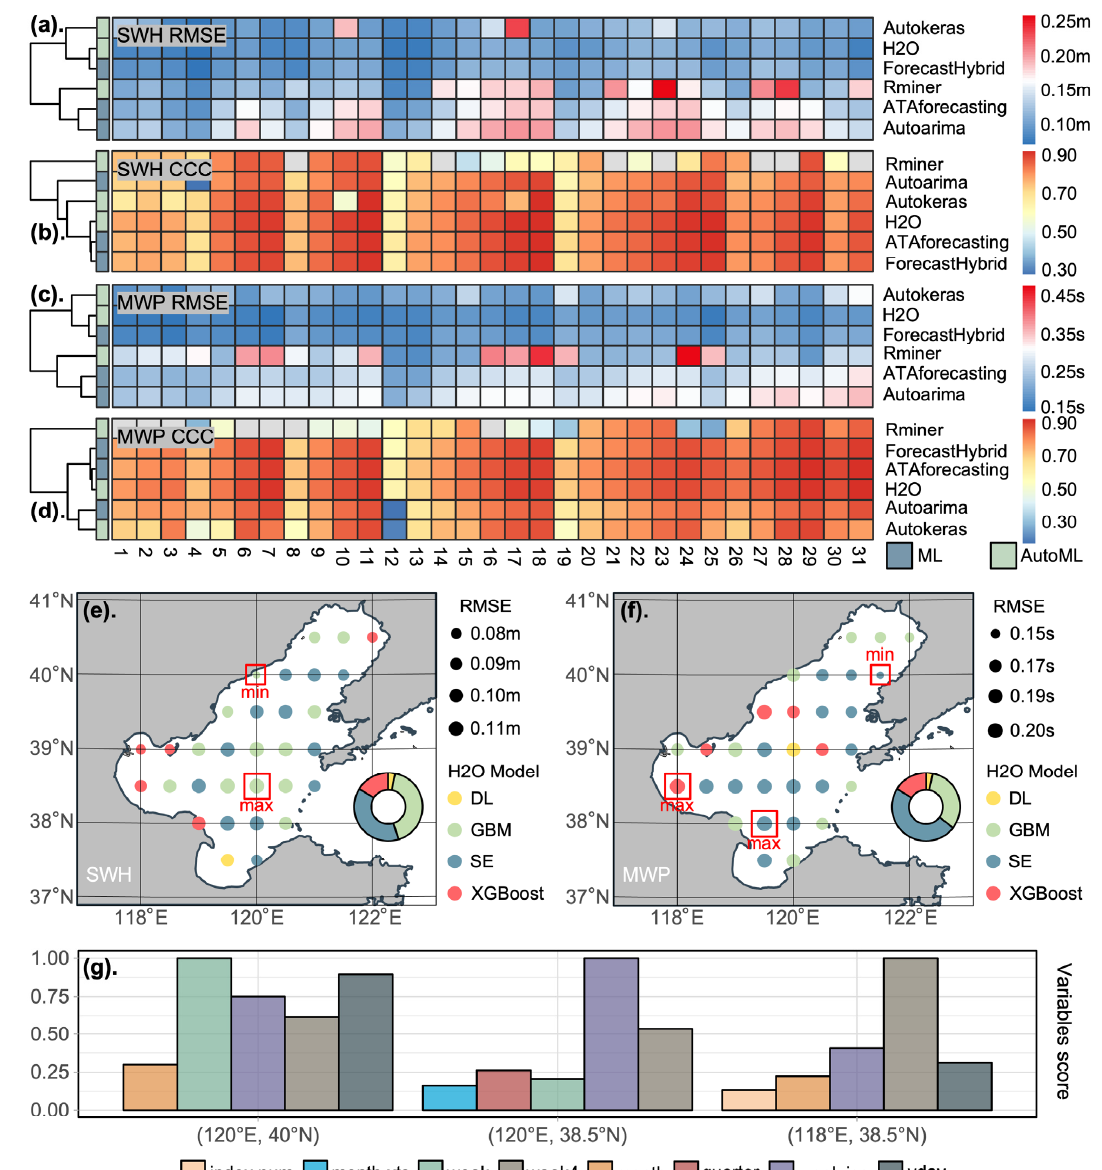
Figure 5. Performance results of the testing set for the six algorithm packages at 31 study coordinate points: RMSE ( a ) and CCC ( b ) of the SWH; RMSE ( c ) and CCC ( d ) of the MWP; minimum RMSE value of the SWH and corresponding algorithm package ( e ); minimum RMSE value of the MWP and corresponding algorithm package ( f ); and feature importance score at the three specific points ( g ).